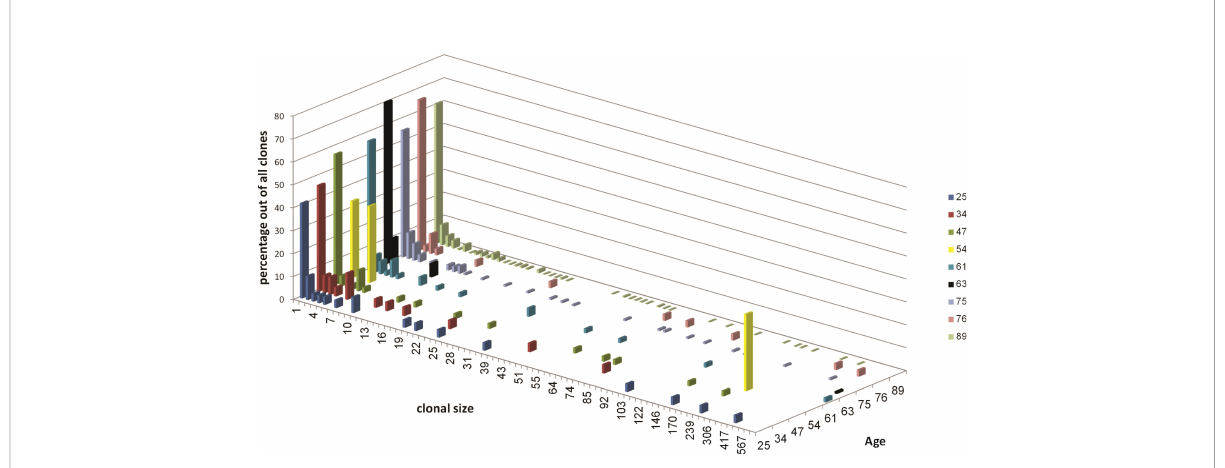
FIGURE 1 Clonal size distribution for each sample. Different colors represent different samples as indicated in the top right. Clonal size is the number of unique sequences in each clone. The distributions are expressed in terms of the percentages of sequences in each sample that belong to clones of each size, out of the total number of sequences in that